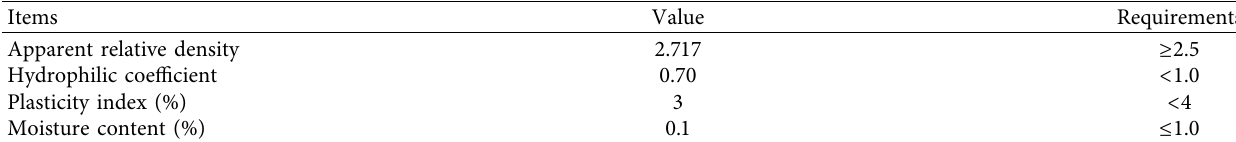
Table 7: Test results of physical properties of mineral powder.